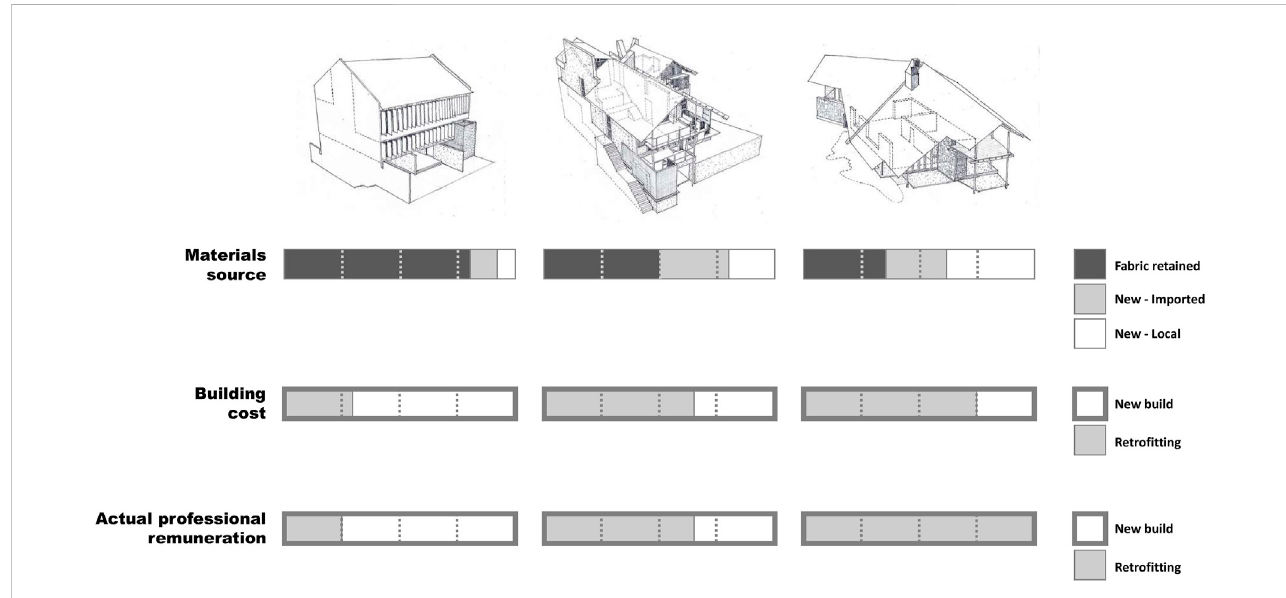
FIGURE 13 Pro-forma analysis of cost-investment bene fi ts and professional remuneration